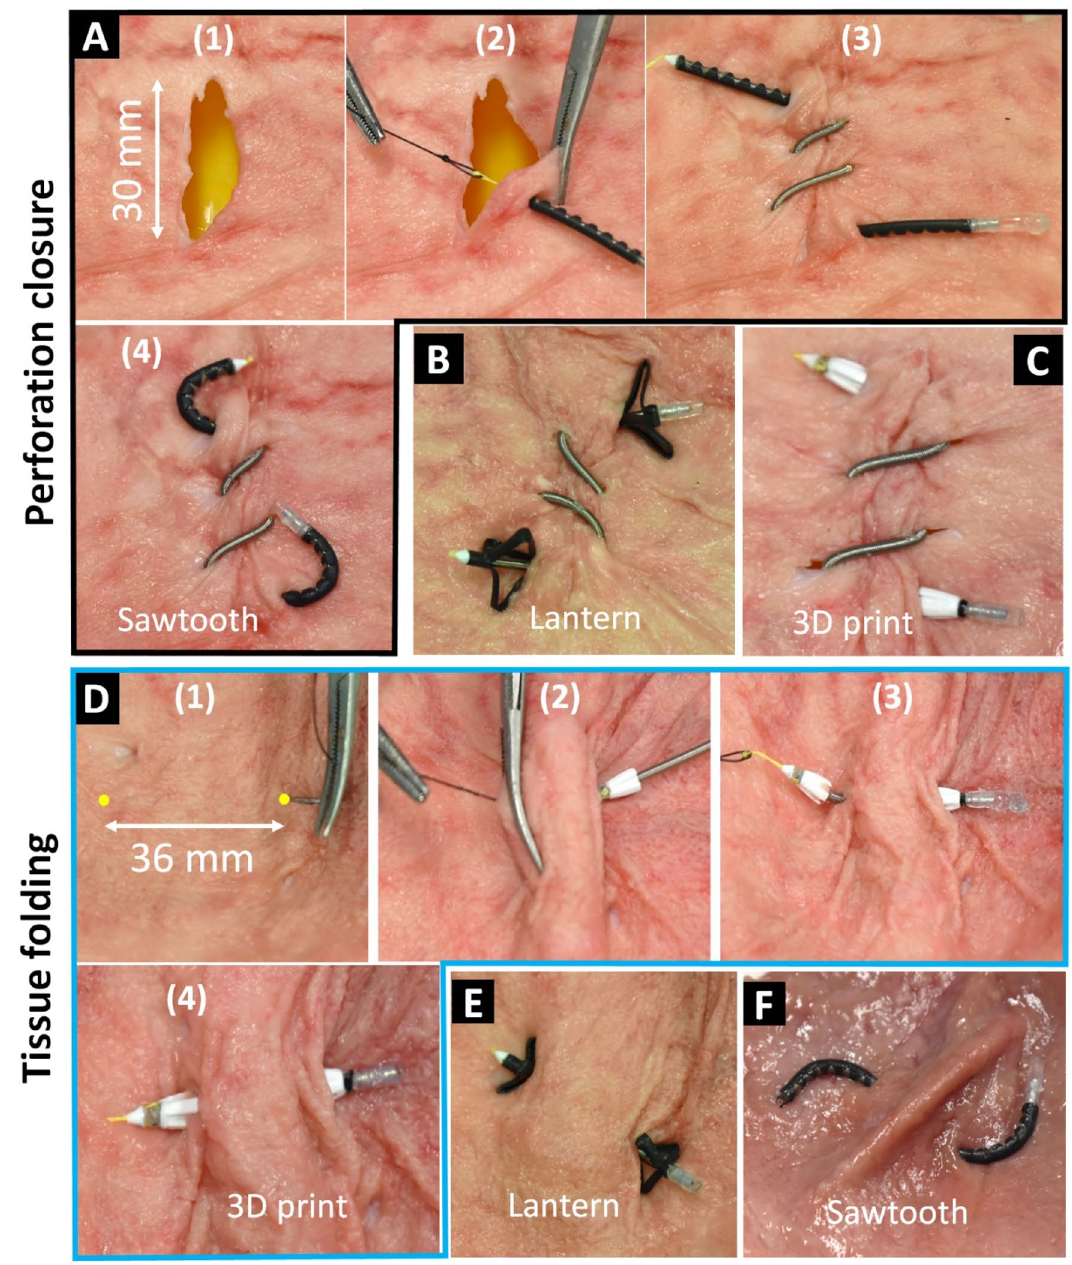
Figure 7. Perforation closure and tissue folding procedure with the S 2 suture-anchors. ( A ) Perforation closure procedure with six running stitches by sawtooth anchor suture. ( B , C ) The same procedure applies to the lantern and 3D printed anchor sutures, respectively. ( D ) Tissue folding procedure (weight loss surgery) by 3D printed anchor suture. ( E , F ) The same procedure applies to the lantern and sawtooth anchor sutures,